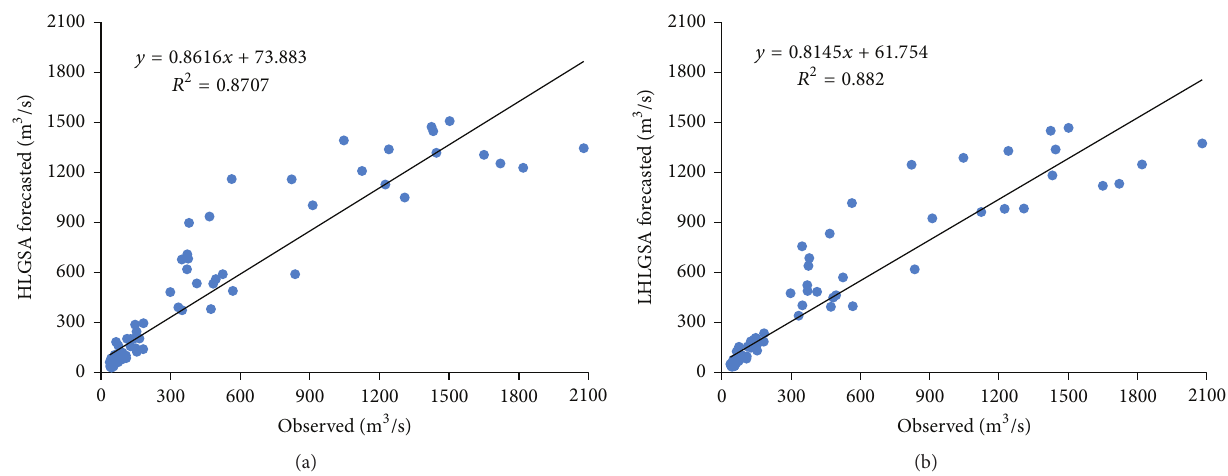
Figure 15: The river flow estimates of the Shyok Basin by LHLGSA and HLGSA models using the data of Astore Basin: DS4 data set.